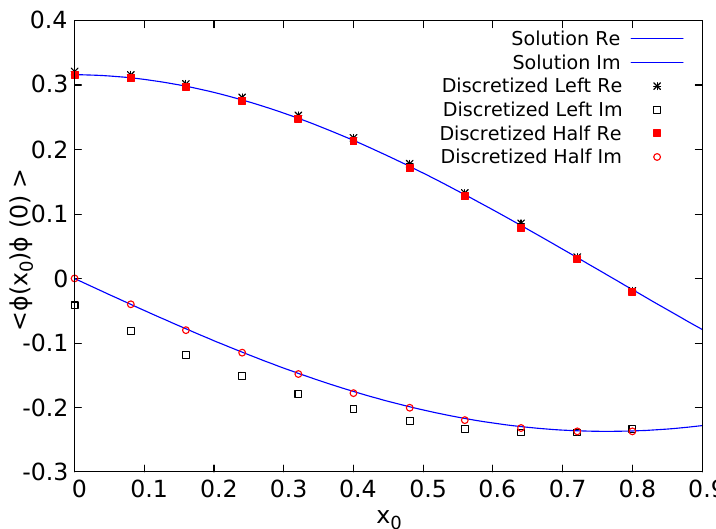
Figure 2 . Visualization of real-time discretization artifacts in the unequal-time correlation function h φ ( x 0 ) φ (0) i . True values (solid lines) are obtained from matrix mechanics in the truncated Hilbert space spanned by 32 energy eigenstates of the harmonic oscillator. Note the shift in the imaginary part when using the first order discretization of eq. (3.8) (open squares) for a lattice spacing of am = 0 . 08 . The symmetric discretization of eq. (3.7) significantly improves the agreement with the continuum results as seen in the open